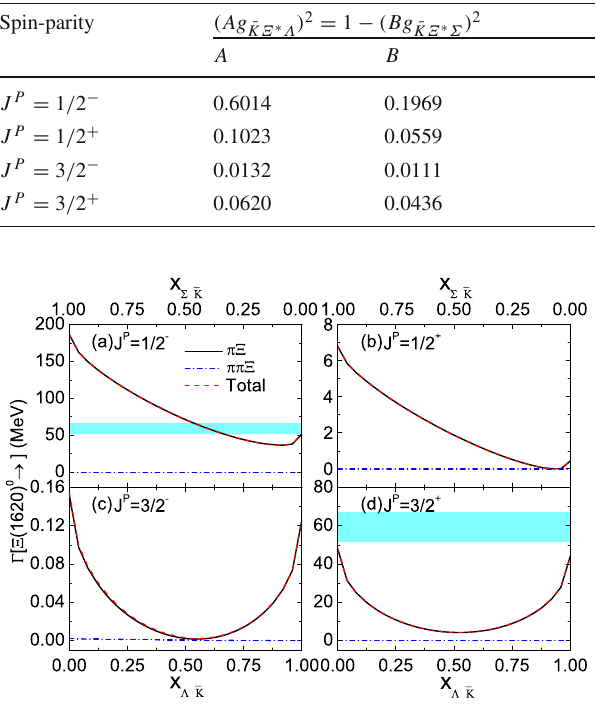
Fig. 5 Partial decay widths of the Ξ( 1620 ) 0 → πΞ (black solid line), Ξ( 1620 ) 0 → ππΞ (blue dash dot line), and the total decay width (red dash line) with different J P assignments depending on the parameter X ¯ and X ¯ .TheLTCyanbandscorrespondtothetotalexperimental K Λ K Σ decay